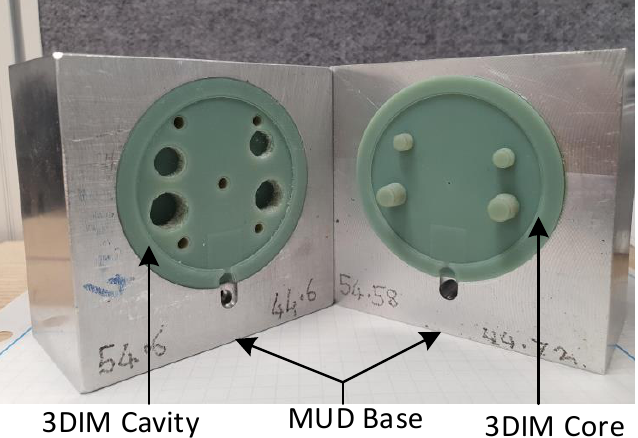
Figure 6. 3DIM inserts (core and cavity) fitted into an Aluminium MUD base.